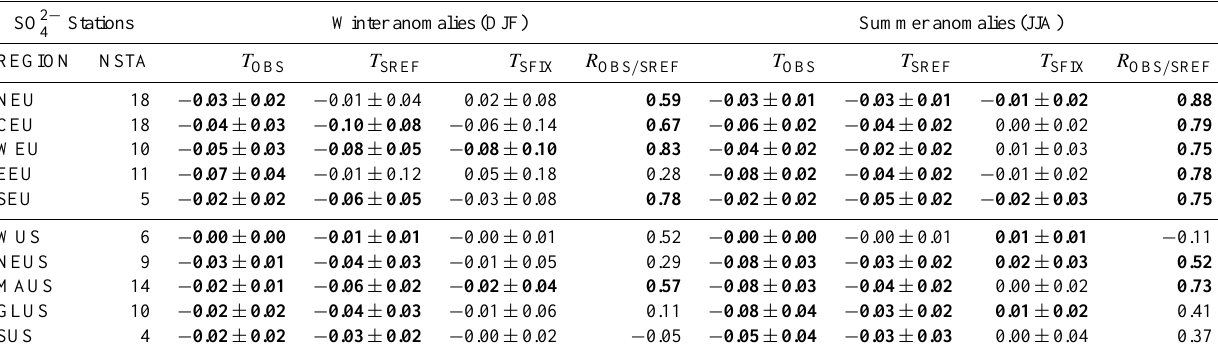
Table B2. Observed and simulated trends of surface SO 2 − seasonal anomalies for European (EU) and North American (NA) stations, 4 grouped as in Fig. 1 (Northern Europe (NEU); Central Europe (CEU); Western Europe (WEU); Eastern Europe (EEU); Southern Europe (SEU); Western US (WUS): North-Eastern US (NEUS); Mid-Atlantic US (MAUS); Great lakes US (GLUS); Southern US (SUS)). The number of stations (NSTA) for each regions is listed in the second column. The seasonal trends are listed separately for winter (DJF) and summer (JJA). Seasonal trends (µg(S)m − 3 yr − 1 ) are calculated for observations ( T OBS ), SREF and SFIX simulations ( T SREF and T SFIX ) as linear fitting of the median surface SO 2 − anomalies of each group of stations (the 95% confidence interval is also shown for each calculated 4 trend). The statistically significant trends (p-value < 0.05) are highlighted in bold. The correlation coefficient between median observed and simulated (SREF) anomalies are listed ( R OBS / SREF ). The statistically significant correlation coefficients (p-value < 0.05) are highlighted in bold. SO 2 − Stations Winter anomalies (DJF) Summer anomalies (JJA) 4 − 0.03 ± 0.02 − 0.01 ± 0.04 − 0.04 ±